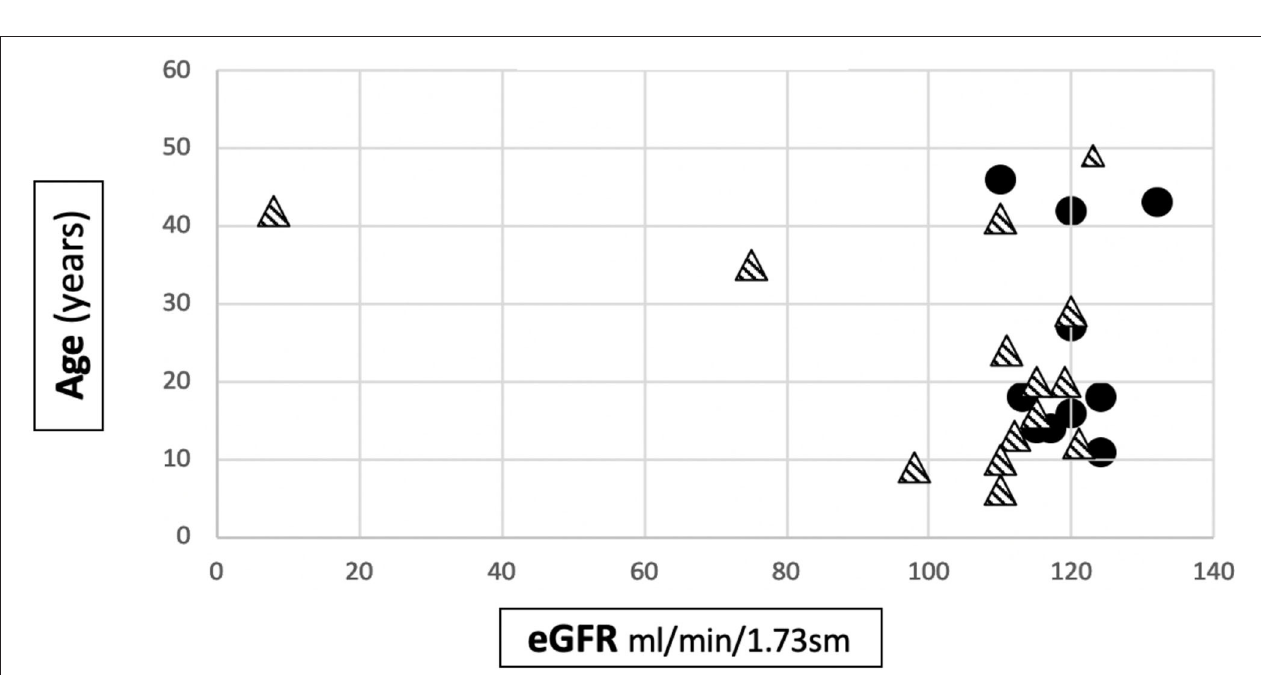
FIGURE 2 | Distribution of age to eGFR correlation in our cohort. (cid:8) patients belonging to Group 1. patients belonging to Group 2.